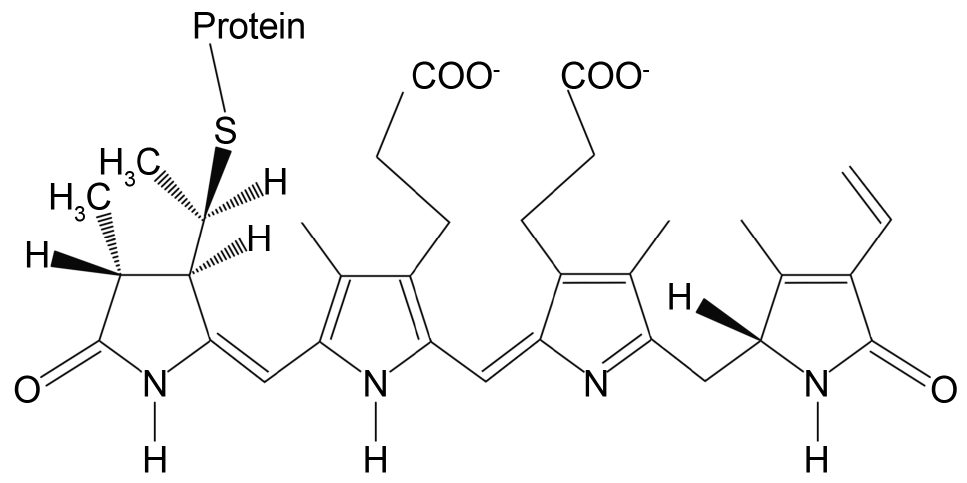
Figure 3. Chemical structure of phycoerythrin bilin